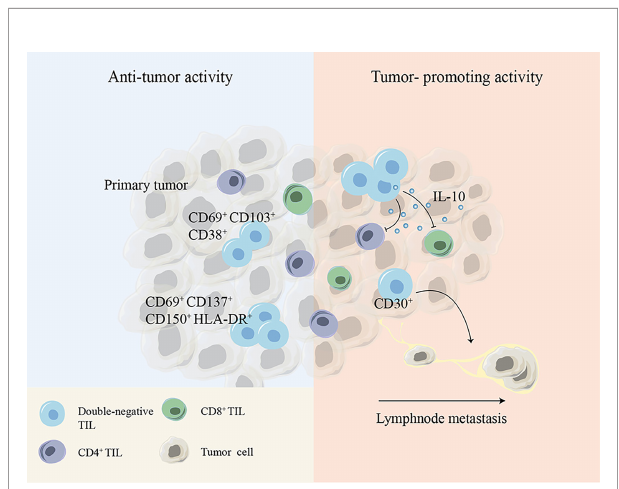
FIGURE 3 | Cell surface molecules or cytokines expressed by DN TILs show debatable antitumor or tumor-promoting activity during tumor development. DN, double-negative; TIL, tumor-in fi ltrating lymphocyte.